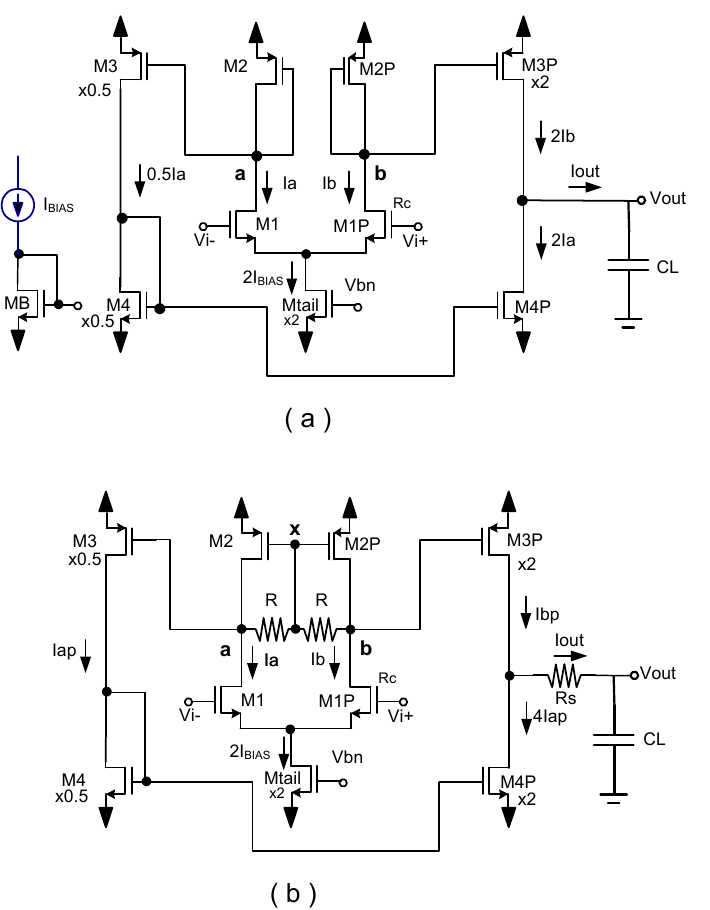
Figure 3. One stage non-cascoded OTAS. ( a ) Conventional three current mirror OTA. ( b ) OTA with resistive local common mode feedback in input stage.